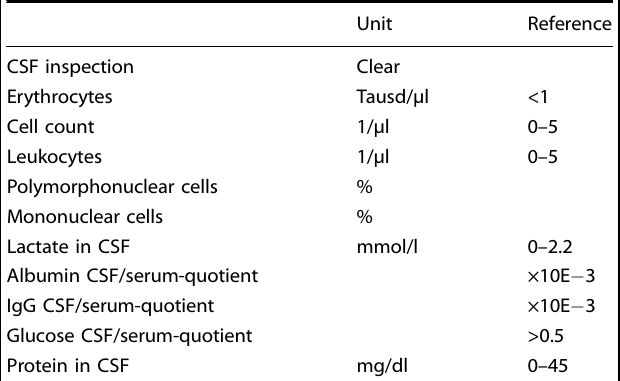
Table 2. Routine diagnostic CSF